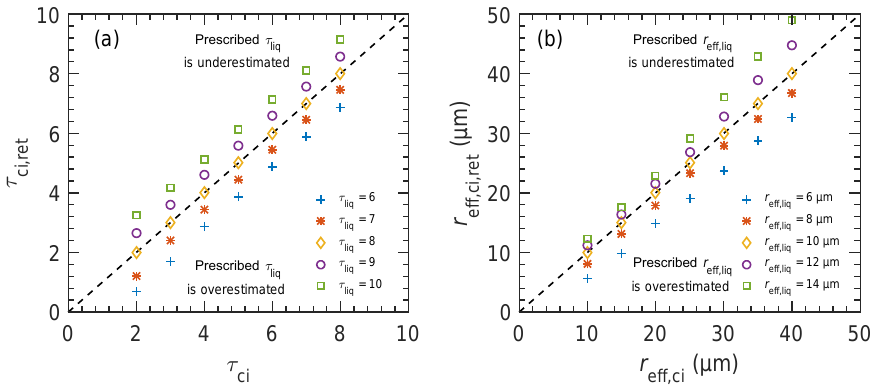
Figure 9. Comparison of synthetically retrieved τ ci (a) and r eff , ci (b) . Calculations in panel (a) are performed by changing τ liq , while the original value is 8. r eff , ci = 20µm and r eff , liq = 10µm are fixed. In panel (b) , r eff , liq is changed, while the original value is 10µm. τ ci = 3 and τ liq = 8 are